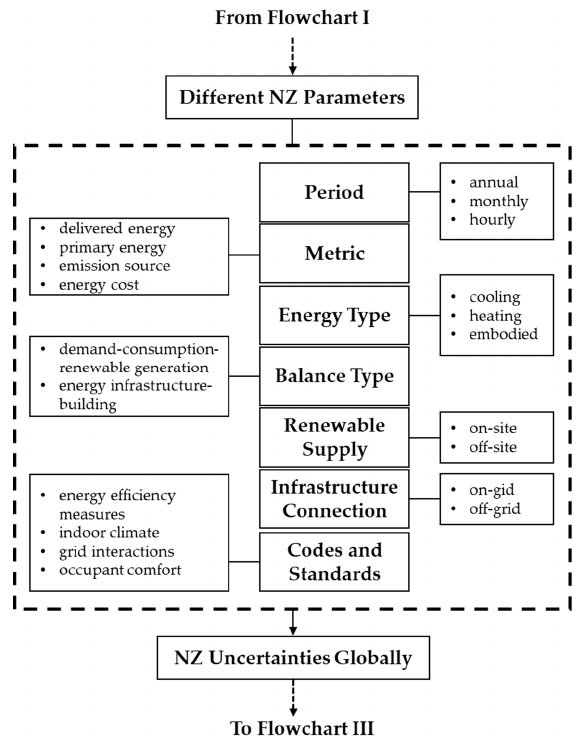
Figure 4. Flowchart II, net zero variable parameters in energy balance.